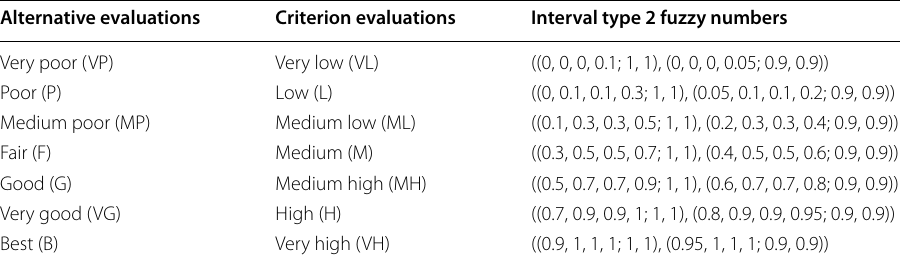
Table 10 Evaluation scales for the criteria and alternatives. Source : Adapted from Chen and Lee (2010), Baykasoğlu and Gölcük (2017) and Dincer and Yuksel (2019) Alternative evaluations Criterion